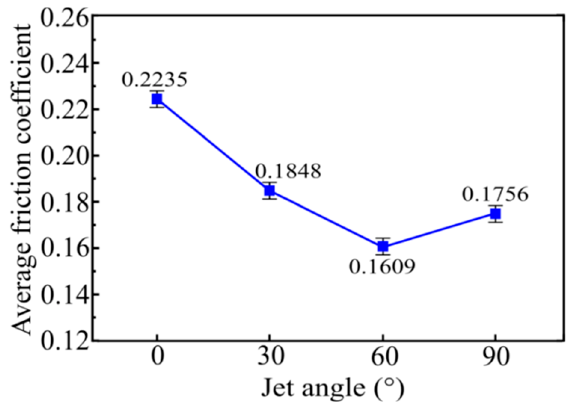
Figure 8. Average friction coefficients at different jet angles.